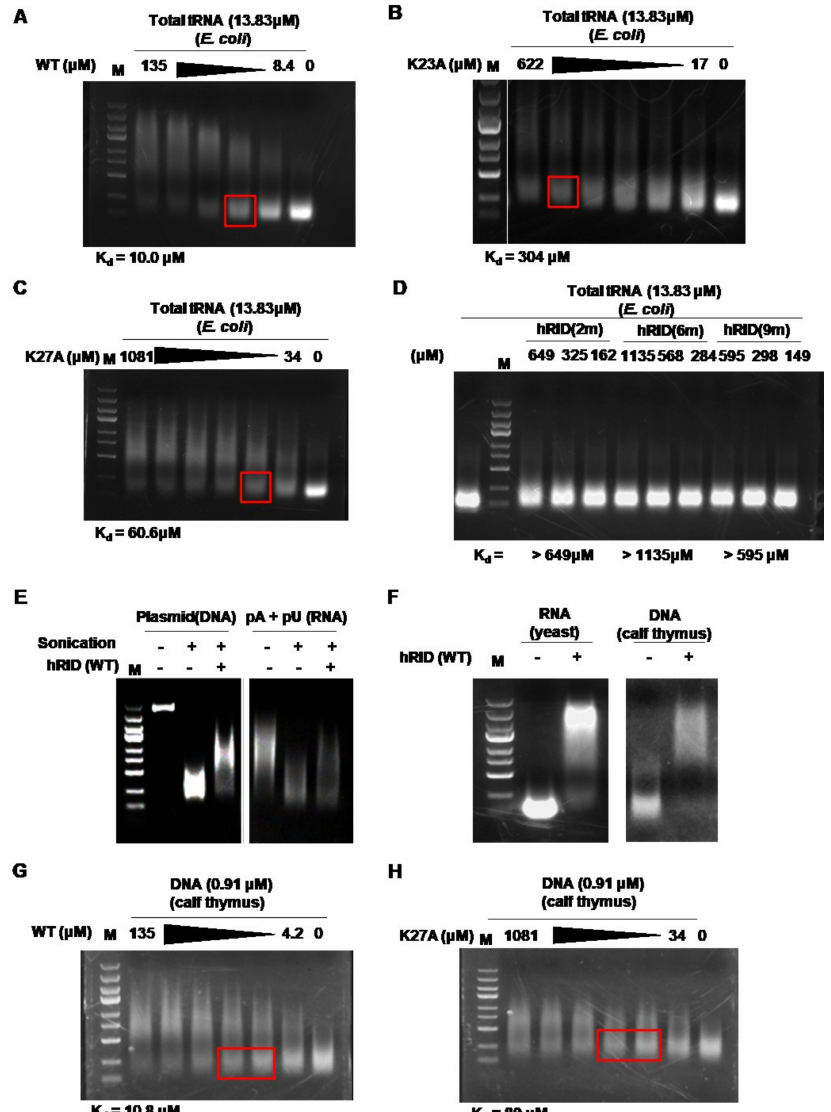
Figure 4. hRID nonspecifically interacts with NAs. ( A – D ) The interactions between total tRNAs from E. coli and ( A ) hRID, ( B ) K23A, ( C ) K27A, ( D ) hRID(2m), hRID(6m), or hRID(9m) were confirmed